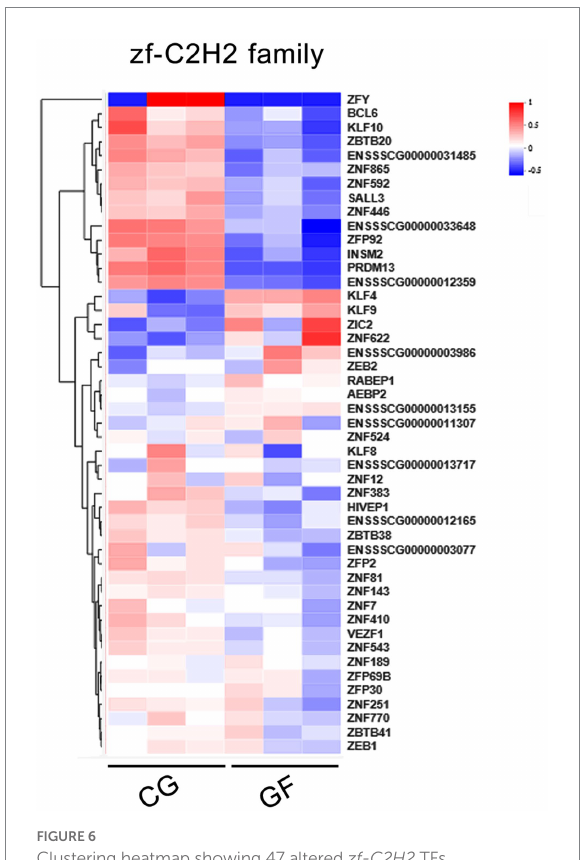
FIGURE 6 Clustering heatmap showing 47 altered zf-C2H2 TFs.